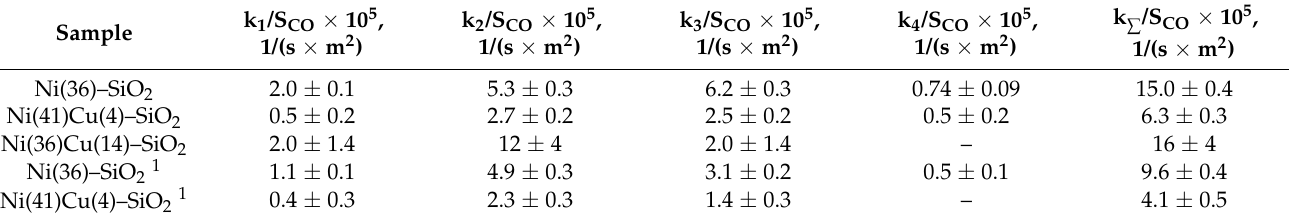
Table 4. Specific catalytic activity of the catalysts in TH of anisole at 250 ◦ C.